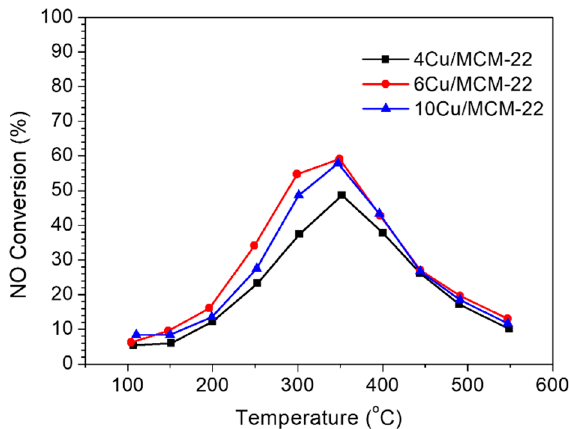
Figure 8. NO conversion in the NO oxidation reaction as a function of temperature over 4Cu / MCM-22, 6Cu / MCM-22 and 10Cu / MCM-22.